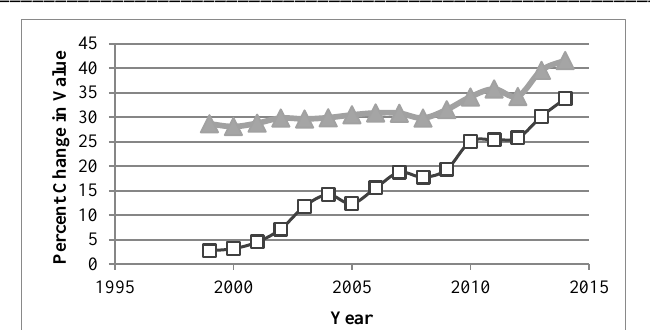
Fig. 1. Relationship between changing rate of Machinery industry (percentage) and the ratio of production to GDP